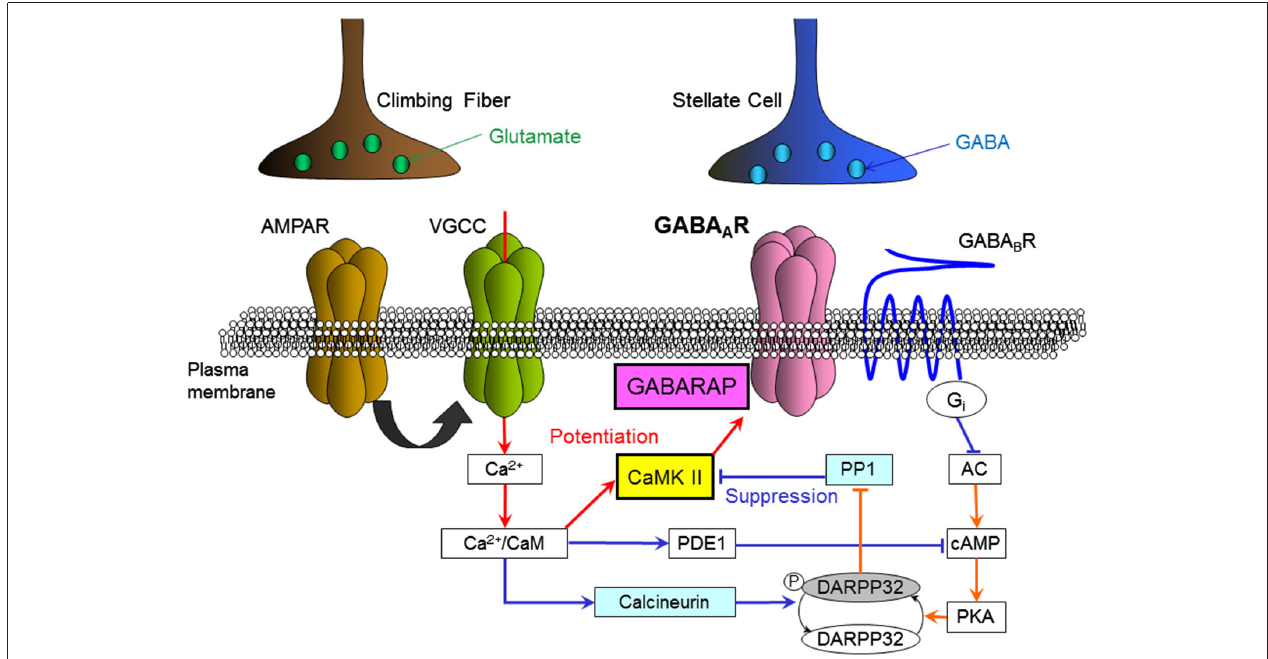
GABA A receptor; GABA B R, GABA B receptor; CaM, calmodulin; CaMKII, Ca 2 + /calmodulin-dependent kinase II; GABARAP, GABA A R associated protein; PDE1, phosphodiesterase 1, PP1, protein phosphatase 1; DARPP32, dopamine and cAMP-regulated phospho-protein 32 kDa; PKA, protein kinase A; cAMP, cyclic-adenosine-monophosphate; AC, adenylyl cyclase; Gi, Gi protein.